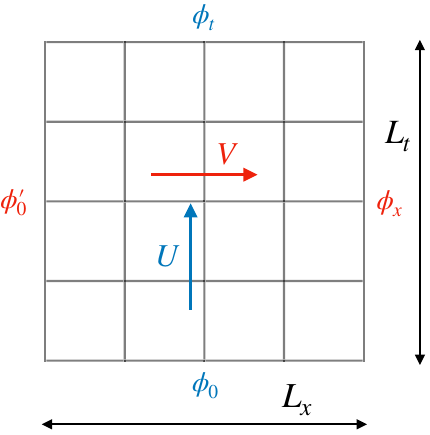
FIG. 1. The geometry of circuit rotation employed in this work illustrated for a 1D system. Given a unitary circuit U that acts on a system of spatial size L x , the wavefunction evolved for time (cid:2) L t is schematically given by (cid:2) φ t | U | φ 0 (cid:3) = D φ( x , t ) e iS (φ) , where , φ x at the boundaries are also being inte- the fields labeled φ (cid:4) 0 grated over in D φ( x , t ) , while φ 0 , φ t act as boundary conditions. Using the same bulk action S , one may then define a rotated cir- cuit V that acts on a system with spatial extent L t , such that the (cid:2) (cid:3) = wavefunction at time L x is (cid:2) φ x | V | φ (cid:4) D φ( x , t ) e iS (φ) . In this 0 rotated circuit, the fields labeled φ 0 , φ t are being integrated over , φ x act as boundary conditions. in D φ( x , t ) , while φ (cid:4) 0 one may represent Z as a path integral in spacetime, (cid:2) Z = D φ( t , { x } ) e iS [ φ ]